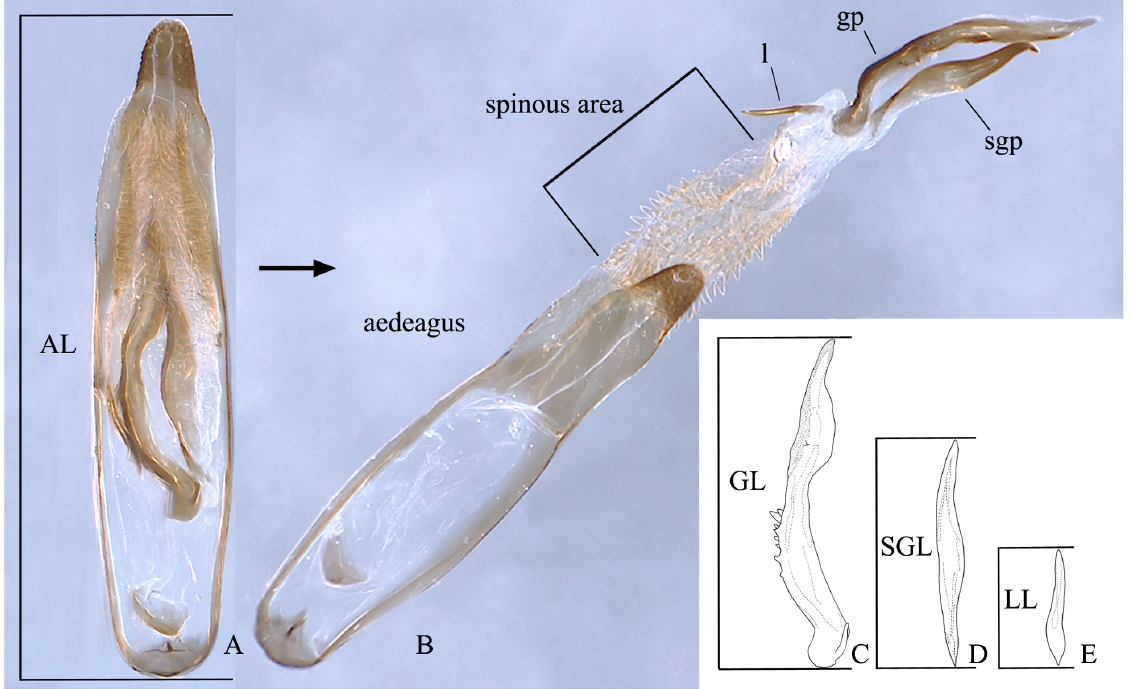
Fig. 7. Aedeagus of Intybia histrio (Kiesenwetter, 1874), showing the terminology and abbreviations for measurement of endophallic structures. A . Aedeagus with holding endophallus. B . Aedeagus with extracted endophallus. C . Gonoporal piece (gp). D . Semi-gonoporal piece (sgp). E . Ligula (l). Abbreviations: AL = Length of aedeagus; GL = length of gonoporal piece; l = Ligula; LL = length of ligula; SGL = length of semi-gonoporal